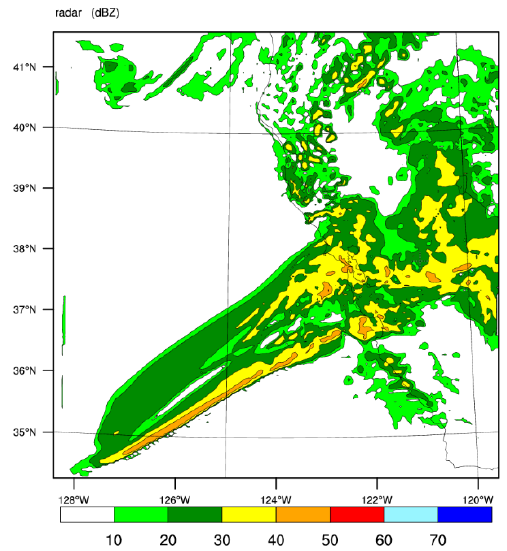
Figure 5. WRF-simulated radar product valid at 13Z on 20 February 2017.